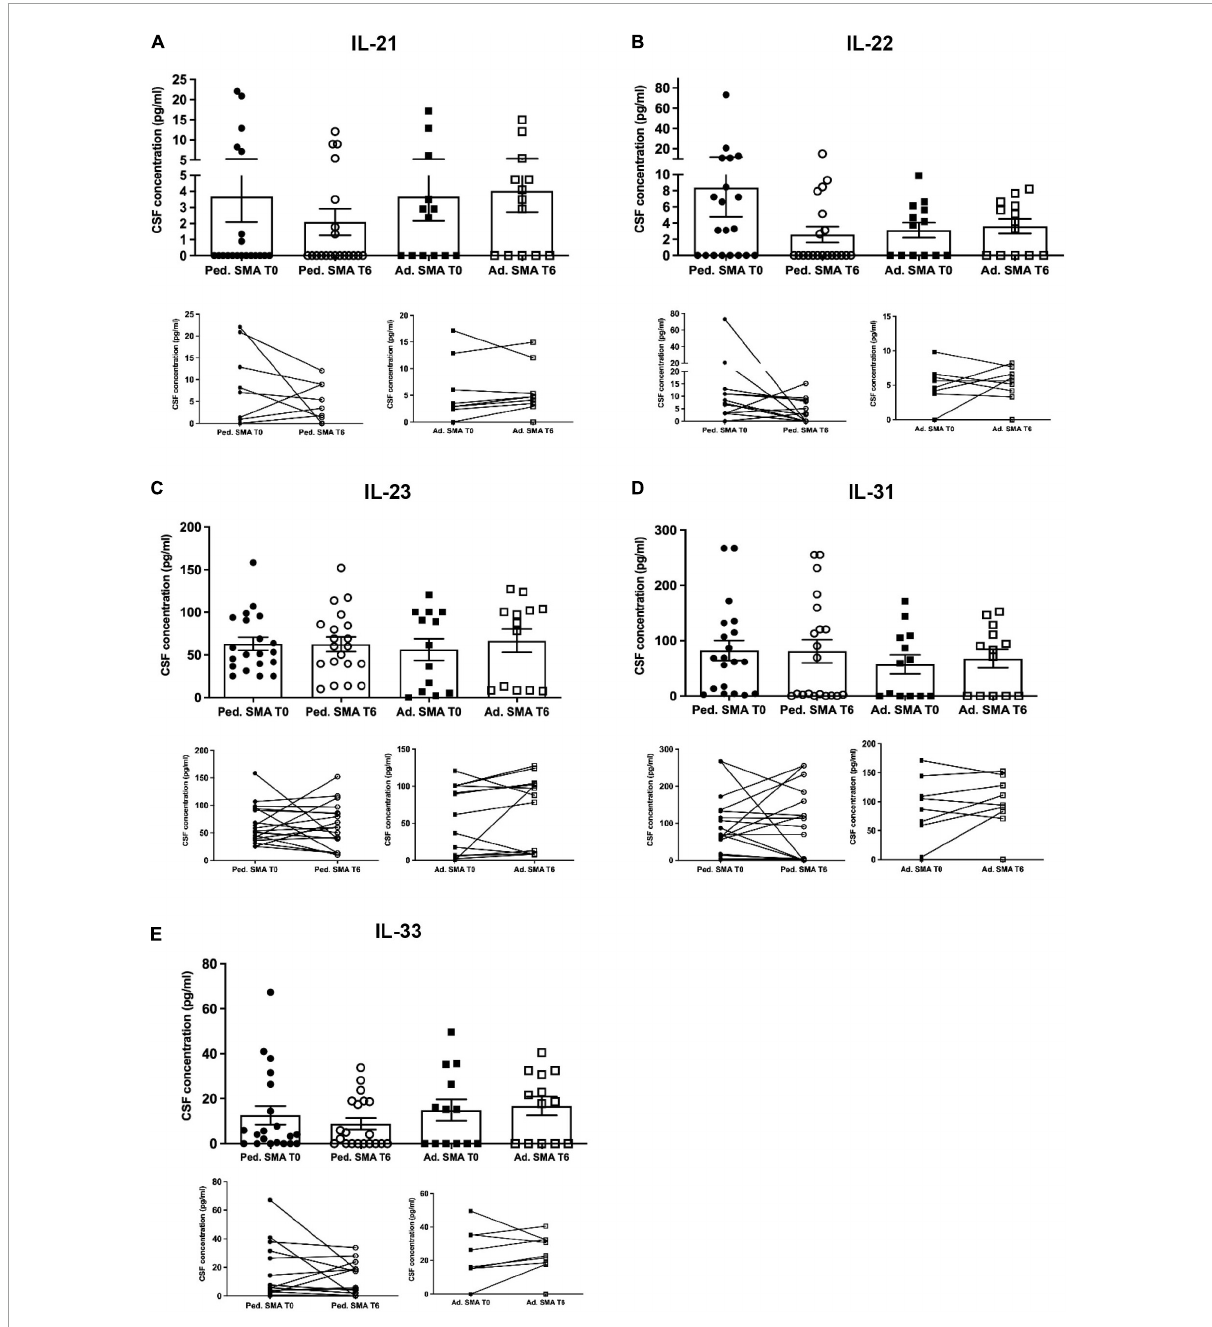
FIGURE6 Levels of cytokines in cerebrospinal fluid (CSF) of pediatric and adult spinal muscular atrophy (SMA) patients. The concentration (pg/ml) of levels of (A) IL-21, (B) IL-22, (C) IL-23, (D) IL-31, and (E) IL-33 were measured in the serum of pediatric (Ped.; circle, N = 21) and adult (Ad.; square, N = 13) SMA patients at baseline (T0 black) and after 6 months of nusinersen treatment (T6 white), and in healthy controls (Ad. CTR; gray triangle) by multiplex immuno assay. Data in the graphs are reported as mean ± SEM for each sample group. The before-after graphs contains the mean cytokine concentration obtained for each patient in the duplicate multiplex immunoassays reactions before and after 6 months of nusinersen treatment (T0 and T6). p > 0.05, Mann–Whitney